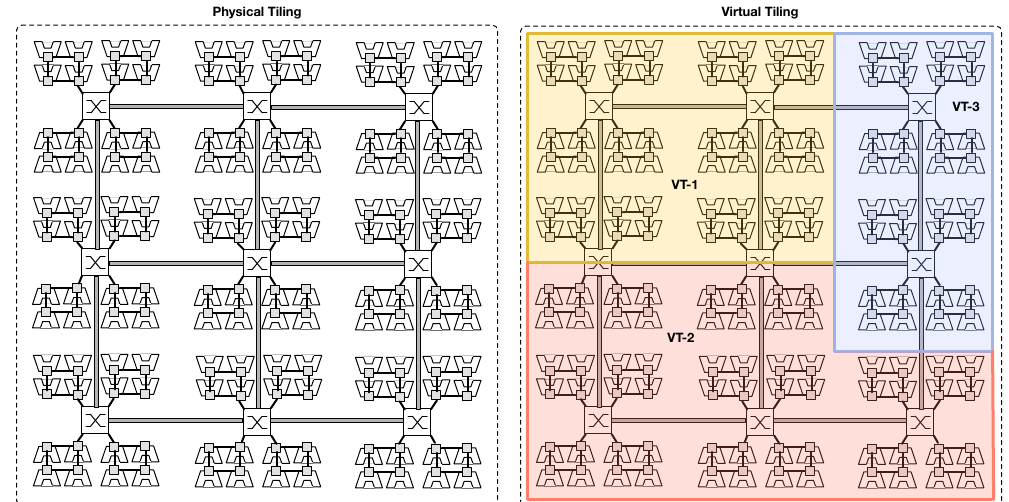
Figure 2. Mapping of virtual tiles (VT- i ) on the physical chip. For instance, three applications/tasks are mapped on the chip (VT-1, VT-2 and VT-3), each using a reserved portion of the hardware